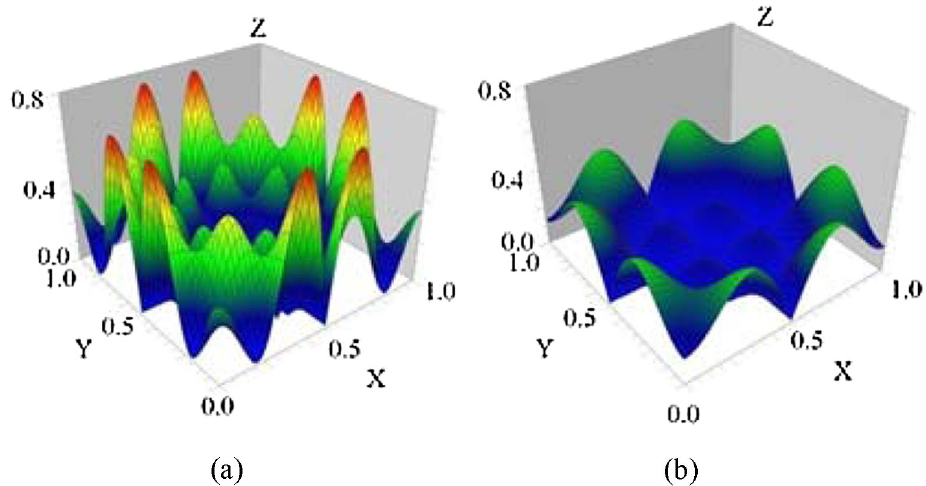
FIG. 4. (Color) (a) The rf magnetic field pattern one-quarter period after the electric field pattern shown in Fig. 3(a) appears. Note strong fields along the cavity walls. (b) The rf magnetic field pattern at a time 1 = 20 of the bunch period later. The peak magnetic field on the walls is smaller by about a factor of 2, than in (a).